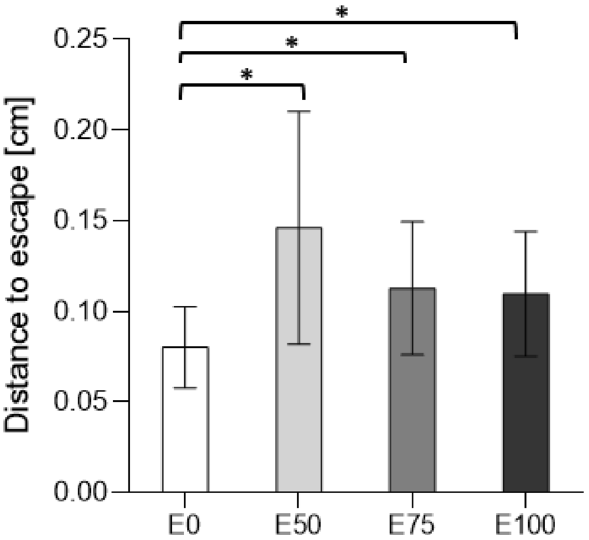
Figure 5. Escape response. Mean ± SE escape response for damselfly larvae exposed to 0, 50, 75, and 100% effluent (E0, E50, E75, and E100, respectively). Statistically significant differences between control and exposed treatments after exposure are indicated with an asterisk (*p <